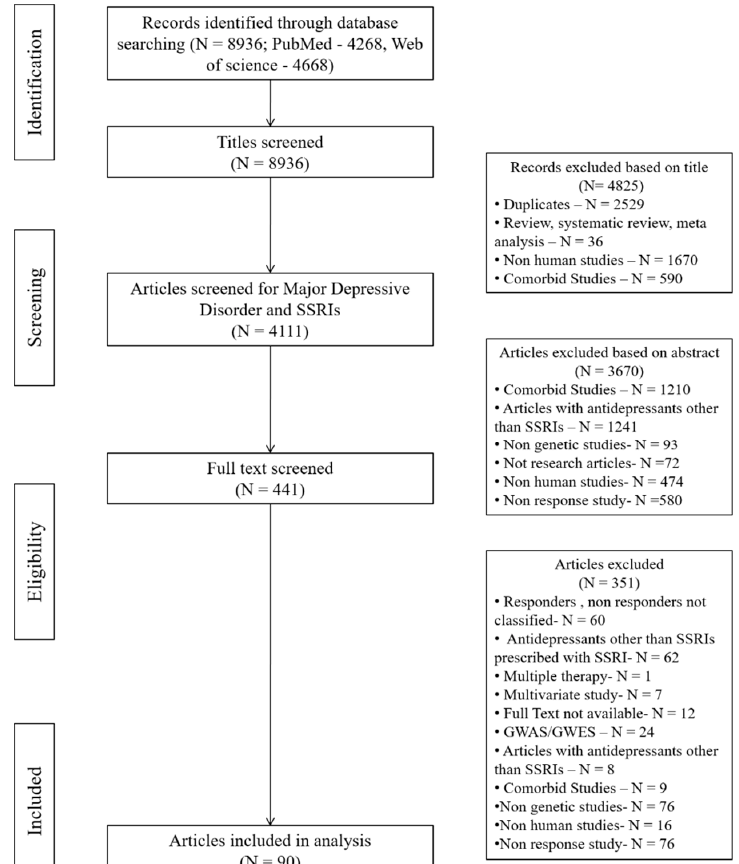
Figure 1. PRISMA flowchart of the study selection process. Reasons for articles that were excluded given in the diagram.